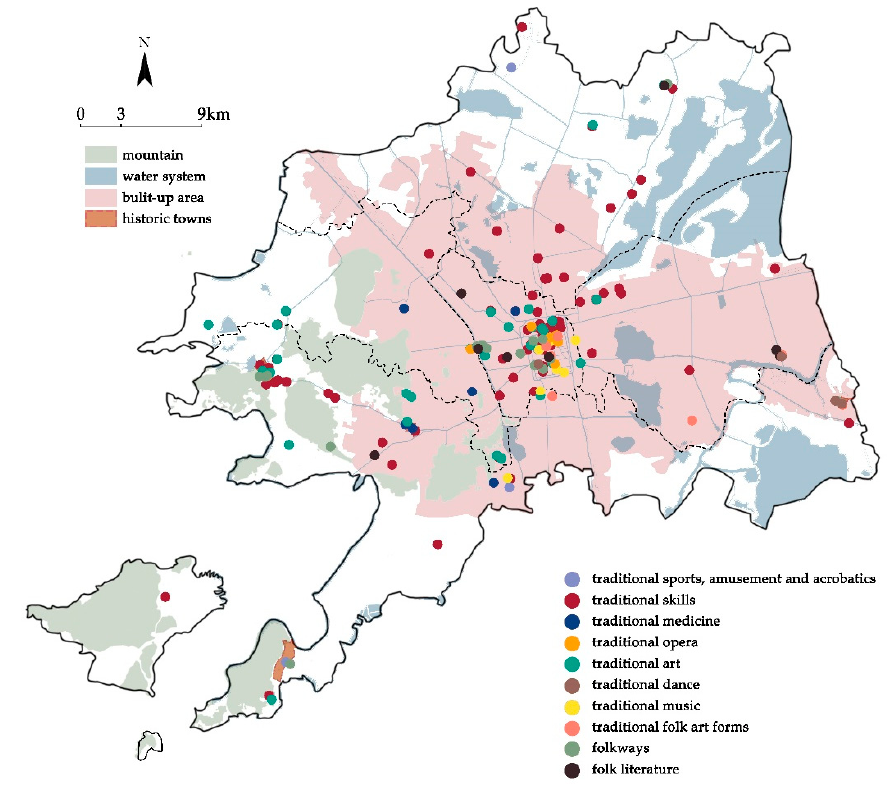
Figure 10. Distribution of intangible heritages.